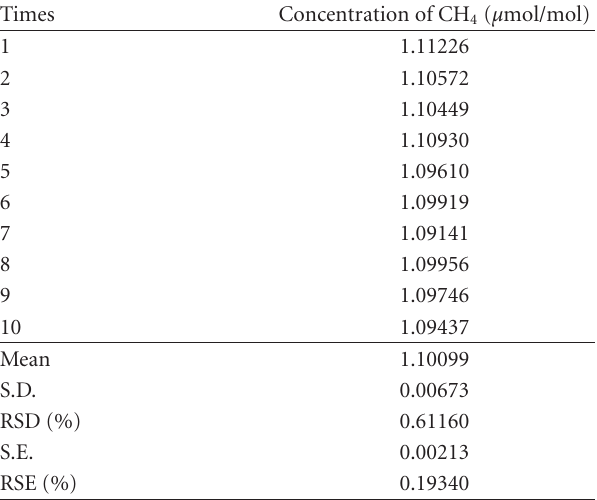
Table 4: Repeatability test of concentration analysis using CH 4 standard gas.